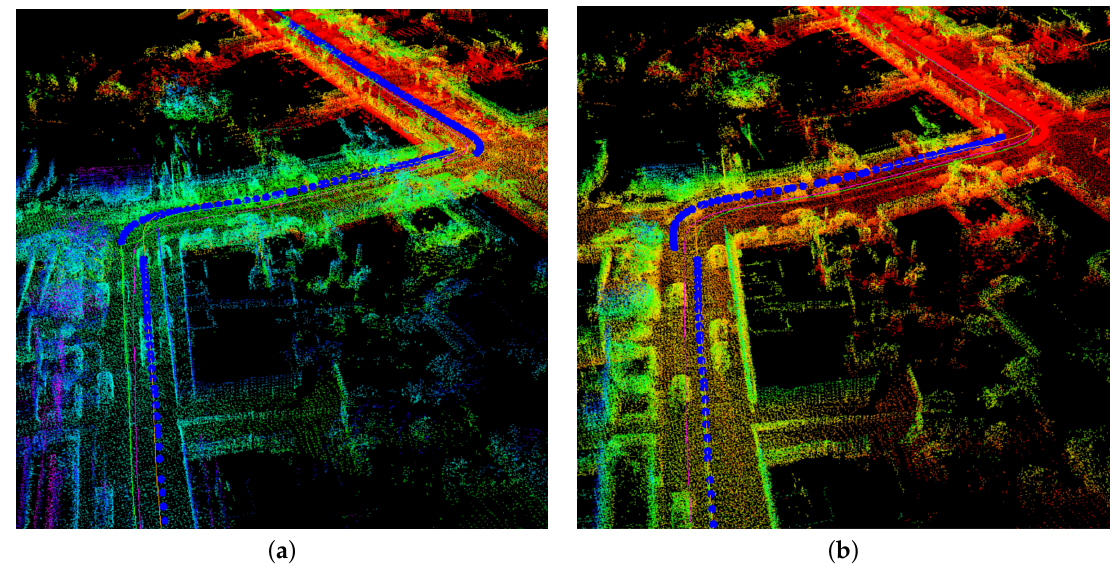
Figure 4. ( a ) 3-D Points cloud without Slerp, ( b ) and 3-D Points cloud with Slerp.